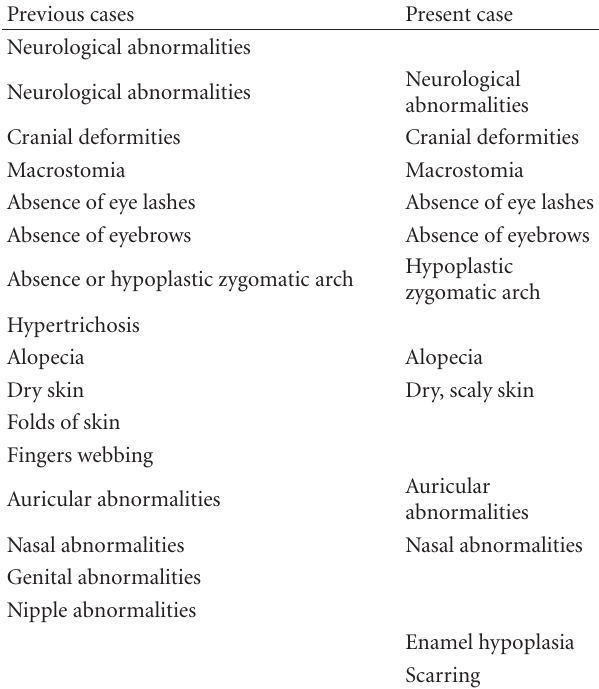
Figure 3: Severe contracture of the left elbow. Table 1: Clinical manifestations.